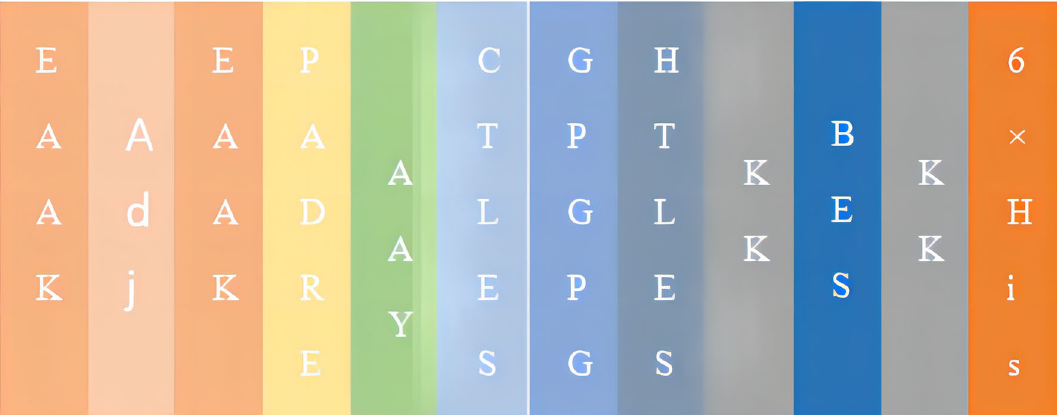
Figure 6. Schematic presentation of the final MEV. As illustrated in the figure, “Adj” stands for β-defensin-3, and “PADRE” stands for PADRE sequence. AAY, GPPGPG, and KK are linkers. BEs include linear B-cell epitopes and constitutive B-cell